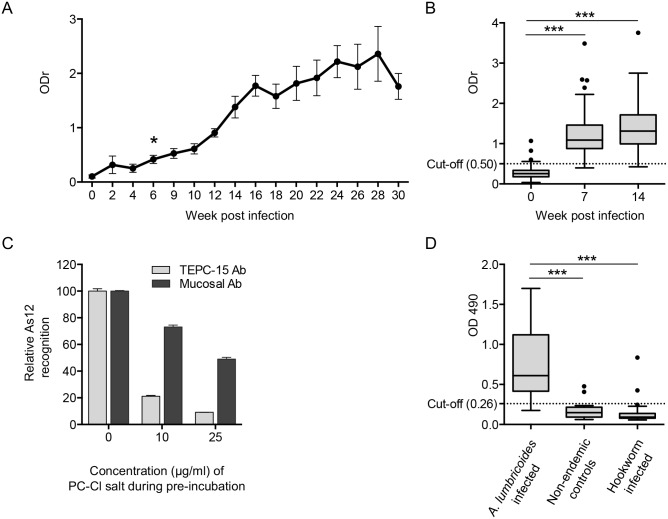
Pigs and humans infected with Ascaris develop antibodies to the As12 antigen.(A) The total IgG response to the As12 purified fraction over time in pigs exposed to trickle infections (500 A. suum eggs/week) over a 30-week time period shows significantly higher IgG responses from 6 weeks after the first challenge infection onwards (P < 0.05). (B) The serological response to the As12 fraction of 91 experimentally infected pigs increased significantly after 7 and 14 weeks of infection (P < 0.001). The optimal cut-off was determined by ROC analysis and set at 0.50 (dotted line). (C) Relative ELISA recognition of As12 by either TEPC-15 monoclonal antibodies or purified mucosal IgG antibodies from trickle infected pigs from group B after pre-incubation with increasing concentrations of PC-Cl salt (0, 10 and 25 μg/ml). (D) Total IgG response against As12 was significantly higher in the 25 A. lumbricoides infected humans than in the 20 uninfected or 24 hookworm-infected individuals (P < 0.001). The cut-off was set at an OD of 0.26 by ROC analysis (dotted line).